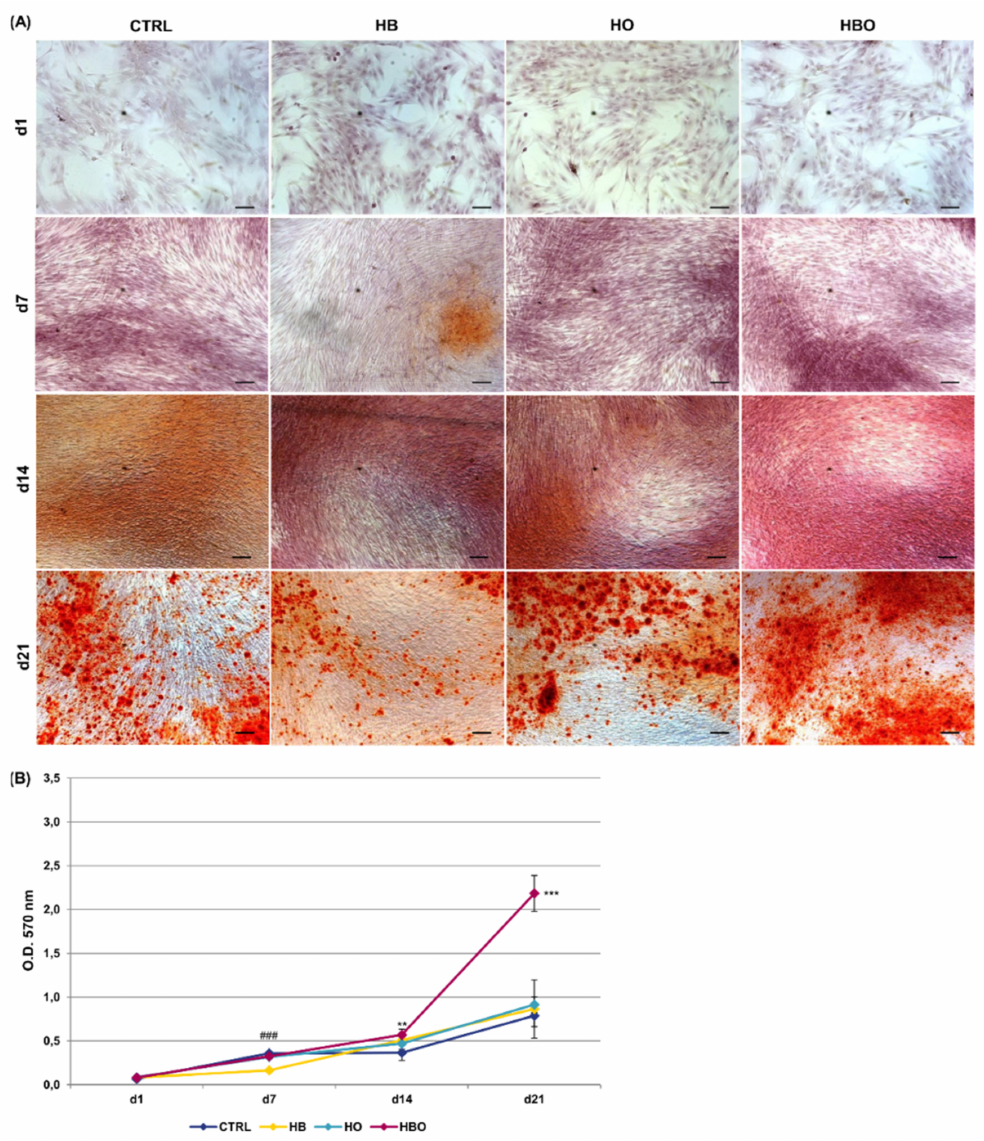
Figure 4. Matrix mineralization in hADSCs after HBO treatment in the presence of inflammation. ( A ) ARS staining and ( B ) quantification of calcium deposits in hADSCs after d1, d7, d14, and d21 of culture in ODM supplemented with 10 ng / mL TNF- α and HBO, HB, or HO treatment. Scale bars 100 µ m. Data are shown as mean ± SD. ** p < 0.01 and *** p < 0.001 indicate statistically significant di ff erence between the HBO-treated cells and the control group, respectively. ### p < 0.001 indicate statistically significant di ff erence between the HB-treated cells and